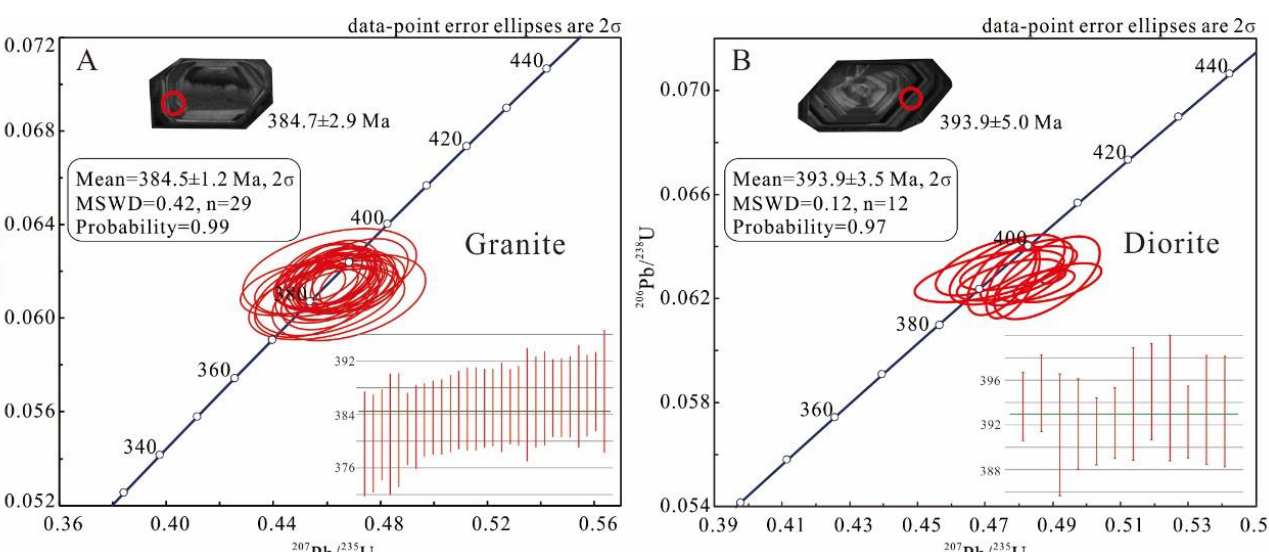
Table 2. Hf isotope data of zircon from granite and diorite dykes of the Jinba gold deposit.